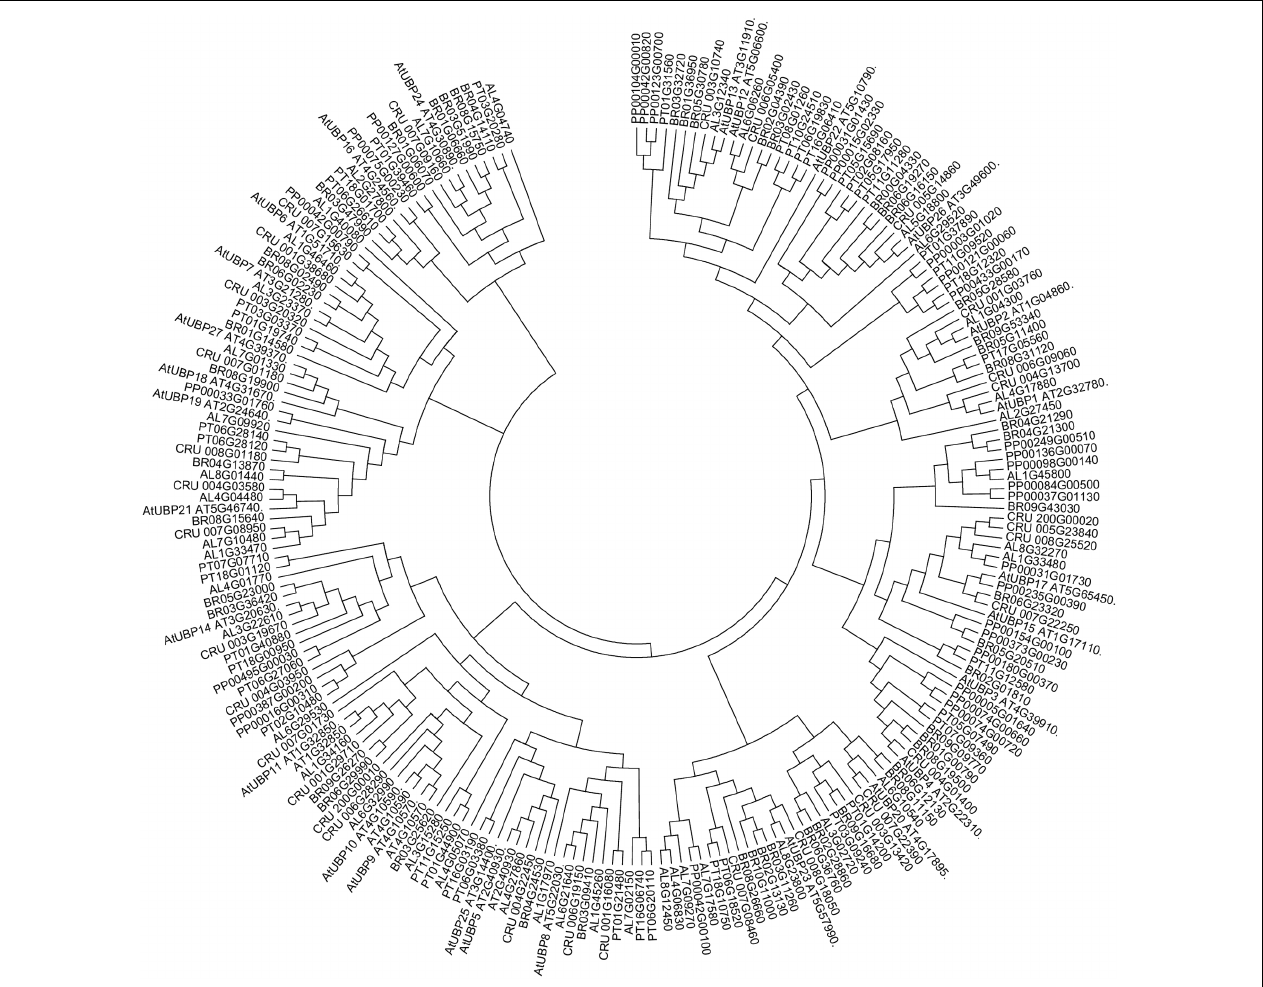
FIGURE 1 | Ubiquitin-specific-processing proteases (UBPs) are highly conserved in plants. Arabidopsis lyrata (AL), Capsella rubella (CRU ), Brassica rapa (BRO), Popolus trichocarpa (PT), Physcomitrella patens (PP). The analysis was conducted in Clustal Omega (Sievers et al., 2014). The tree was edited for easier visualization in MEGA 7. Sequences obtained from PLAZA (Proost et al.,